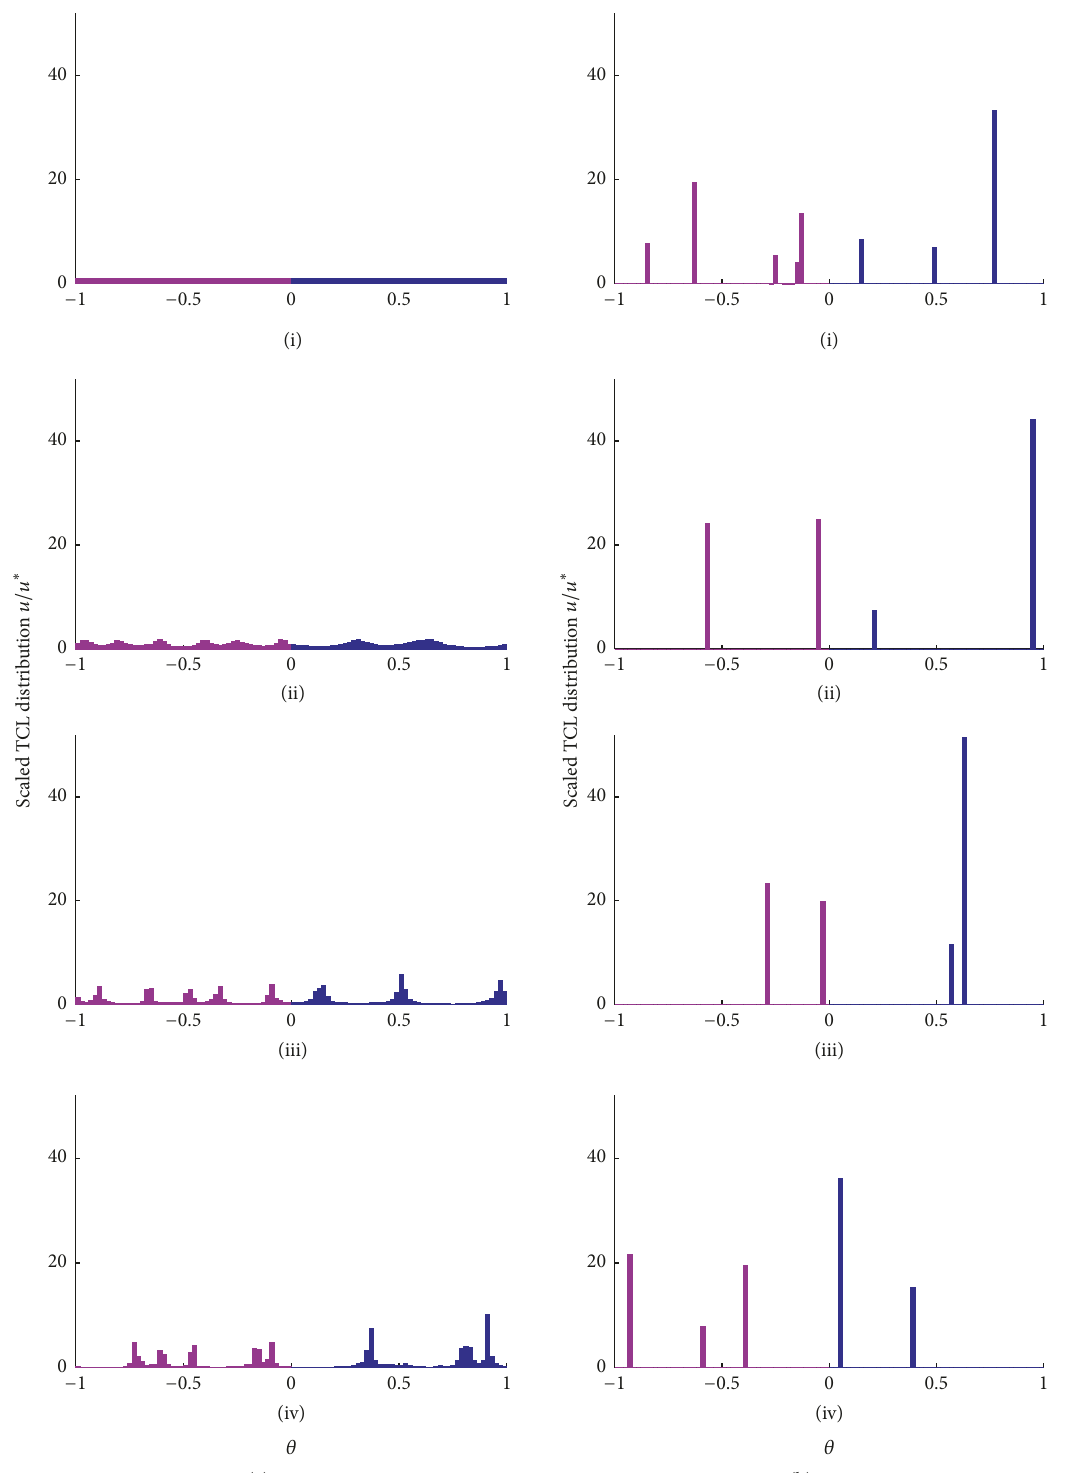
Figure 9: Final fridge distributions after 10 days in 𝜃 -space, with properties as given in Table 3 and initial distributions as shown in Figure 8. Perturbations have grown (except for the zero perturbation case